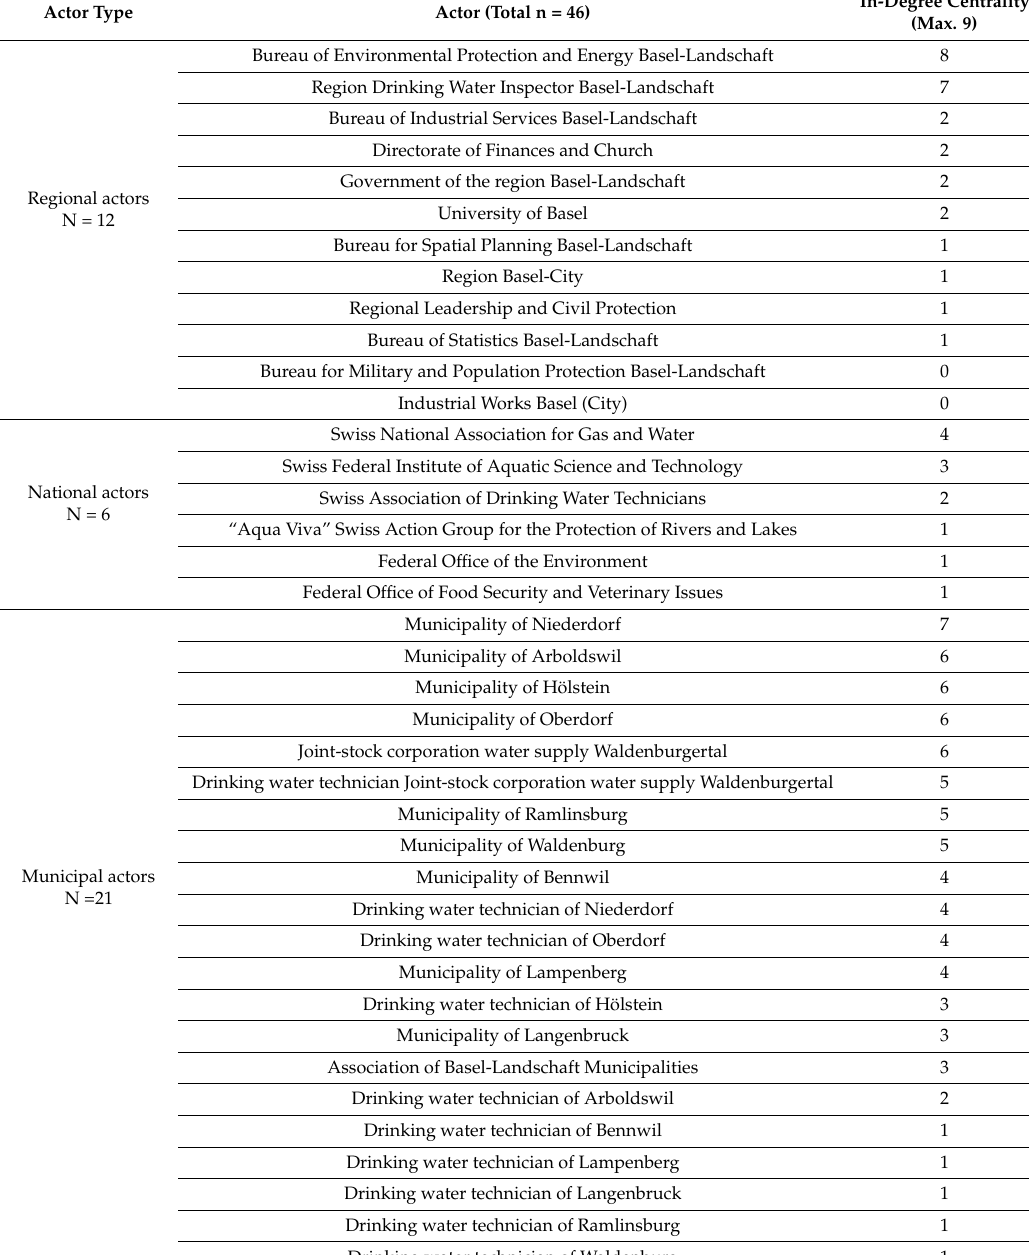
Table A2. In-degree centralities in Case